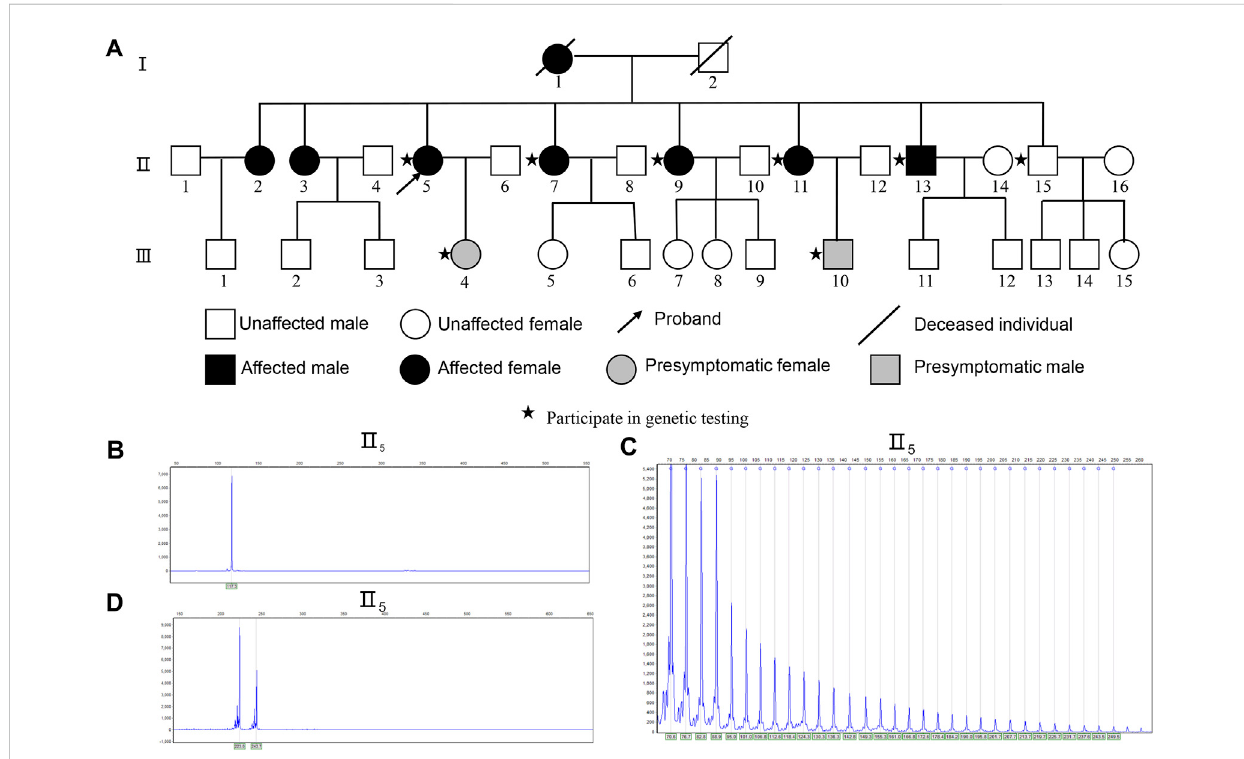
FIGURE 1 Identi fi cation of Expanded GGCCTG Repeat within NOP56 in the SCA family pedigree. (A) Genealogical structure of the family with spinocerebellar ataxia. The outco me of RP-PCR about II 5 (B) The conventional PCR of II 5 showed only one peak indicated homozygous or with a signi fi cant expansion. (C) II 5 showed a characteristic ladder pattern with a 6-bp periodicity indicated repeat expansion in NOP56 . (D) The conventional PCR of outcome II 5 shows the CAG repeat number is 41 times in TBP gene, Sanger sequencing shows the CAG repeat number is